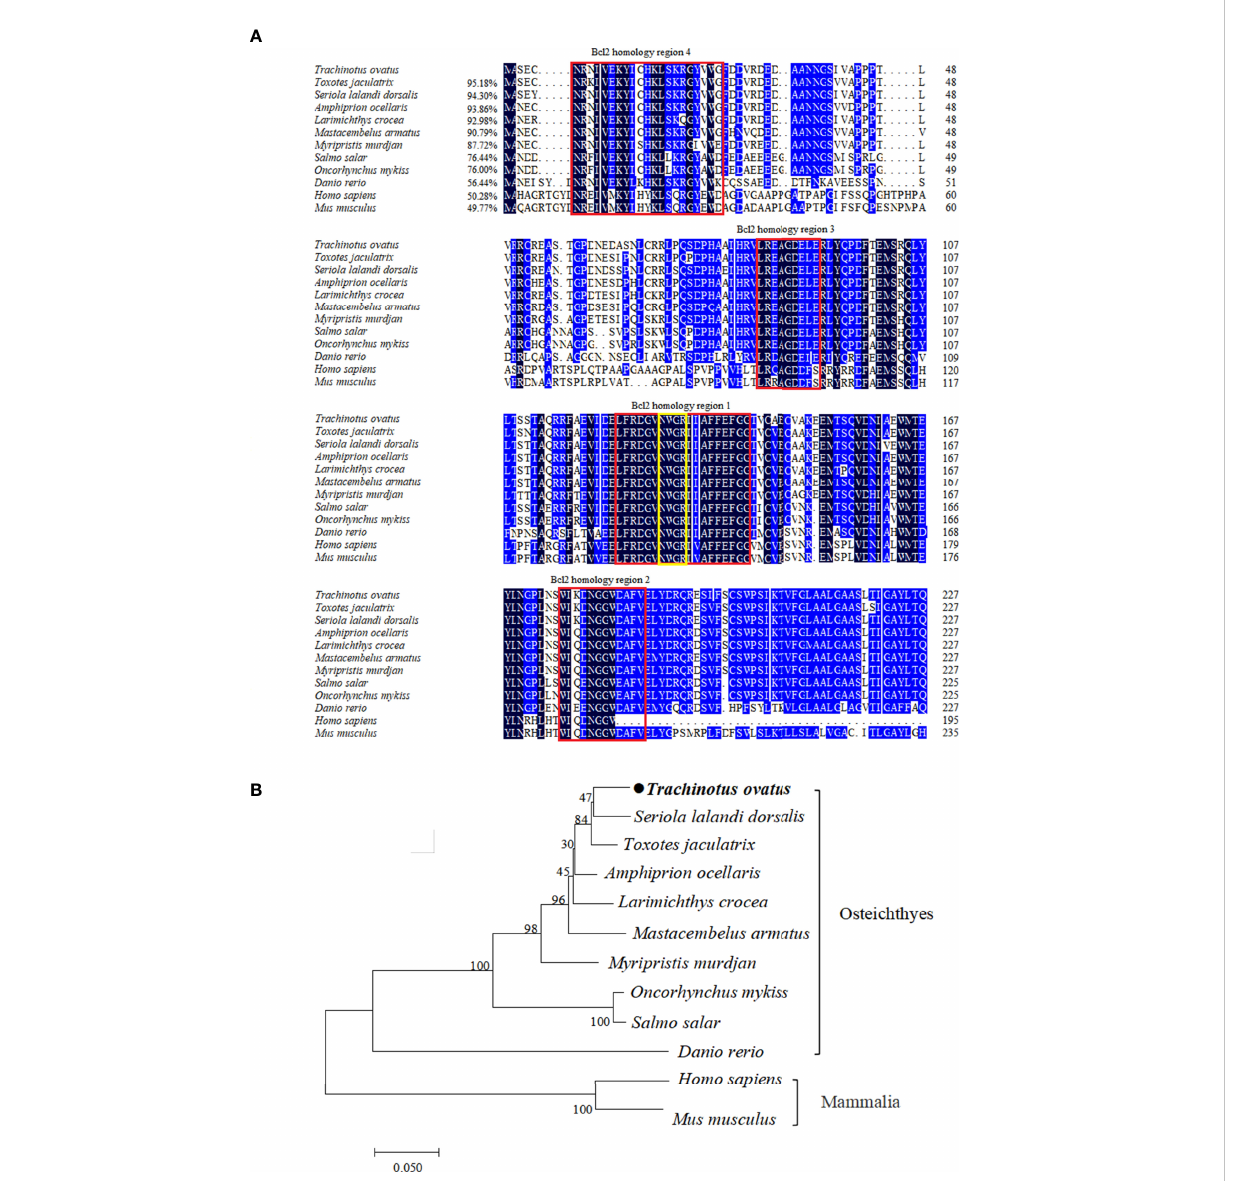
FIGURE 1 Multiple alignment and phylogenetic analysis of TroBcl2 amino acid sequence with Bcl-2 from other species. Multiple alignment of TroBcl2 with Bcl- 2 from other species was performed (A) . The sequence similarities between TroBcl2 and other species Bcl-2 were shown in parentheses. The black background color represents fully conserved amino acids, while blue background color represents amino acids with ≥ 75% identical among the aligned sequences. Four Bcl-2 homology regions were shown in red boxes. The conserved “ NWGR ” motif was marked with yellow box. GenBank accession numbers of Bcl-2 amino acid sequences used for homologous alignment can be found in Table S2. The phylogenetic relationship between TroBcl2 of Trachinotus ovatus with Bcl-2 from other species was analyzed by MEGA6 using the neighbor-joining method with